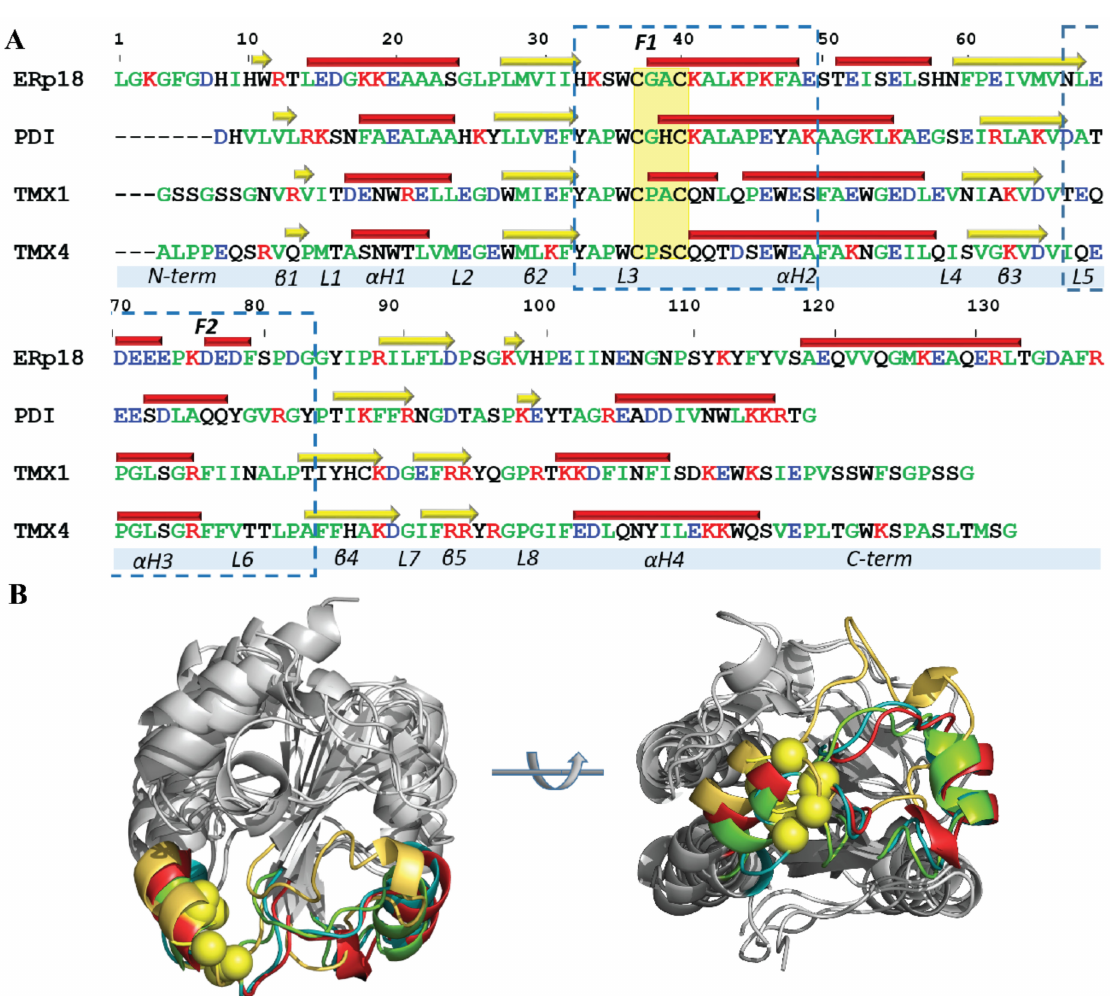
Figure 4. Sequence and folding of Trx-like proteins. ( A ) Alignment of the sequences and the secondary structure assigned to a mean conformation of the concatenated trajectory of each studied protein. Residues are coloured according to their properties—the positively and negatively charged residues are in red and blue, respectively; the hydrophobic residues are in green; the polar and amphipathic residues are in black; the CX 1 X 2 C motif is highlighted by a yellow background. The α -helices and β -strands are shown as red batons and yellow arrows, respectively. Secondary structure labelling is shown below the Tmx4 sequence. ( B ) The superimposed 3D structures of the Trx-fold proteins are shown in two orthogonal projections. The proteins are drawn as ribbons, with the cysteine residue as yellow balls. The F1 and F2 regions (and secondary structure labels) that are potentially involved in target recognition and/or the electron transfer reaction are outlined by dashed lines in ( A ) and differentiated by colour in ( B ) to distinguish between the proteins: ERp18 (dark yellow), PDI (red), Tmx1 (green) and Tmx4 (dark